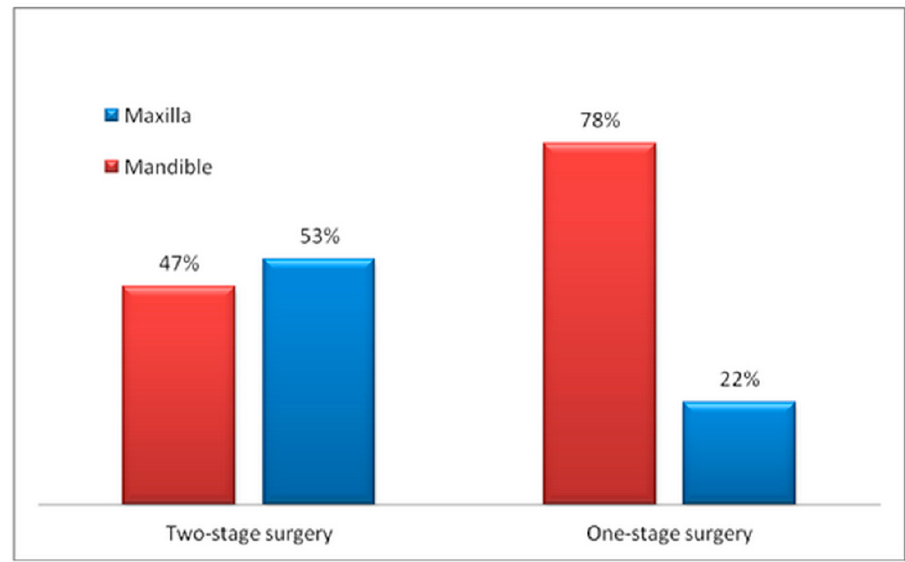
Figure 2. The correlation between maxilla/mandible implant location and the surgical technique.